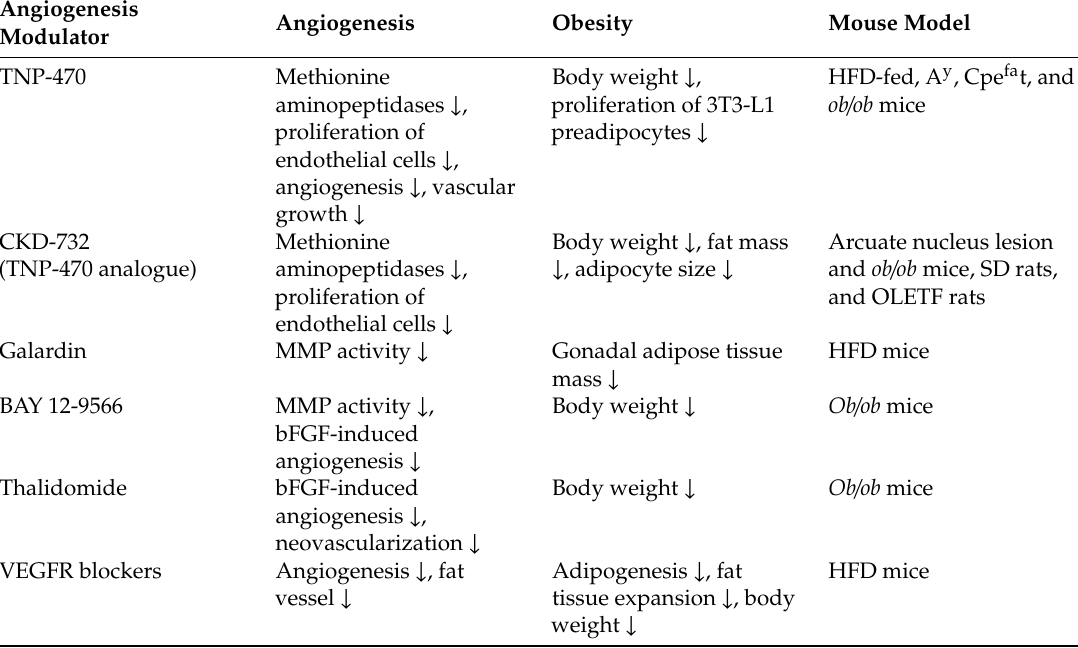
Table 3. E ff ects of angiogenesis modulators on angiogenesis and